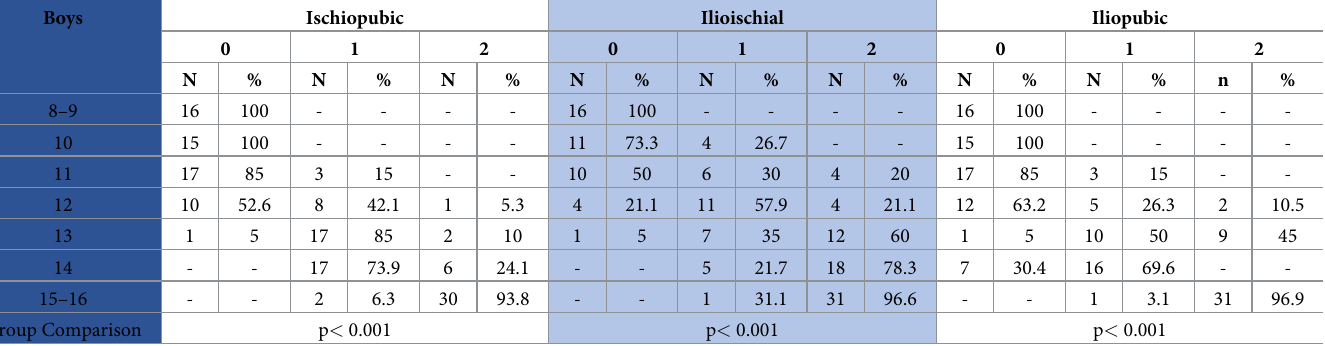
points are open, and the iliopubic synchondrosis junction point is generally open in all boys aged ten years. The table also shows that boys over 14 years of age do not have fully open junc- tions in ischiopubic-ilioischial-iliopubic synchondrosis regions. Furthermore, in all the chil- dren aged from 15–16, there were closed ischiopubic-ilioischial-iliopubic synchondrosis joints; there were no closed synchondrosis joints at the ischiopubic and iliopubic junctions for children age 11 and below, and there was no closed synchondrosis under the age of 10 for ilioischial regions. The table shows that there were statistically significant differences between the groups.